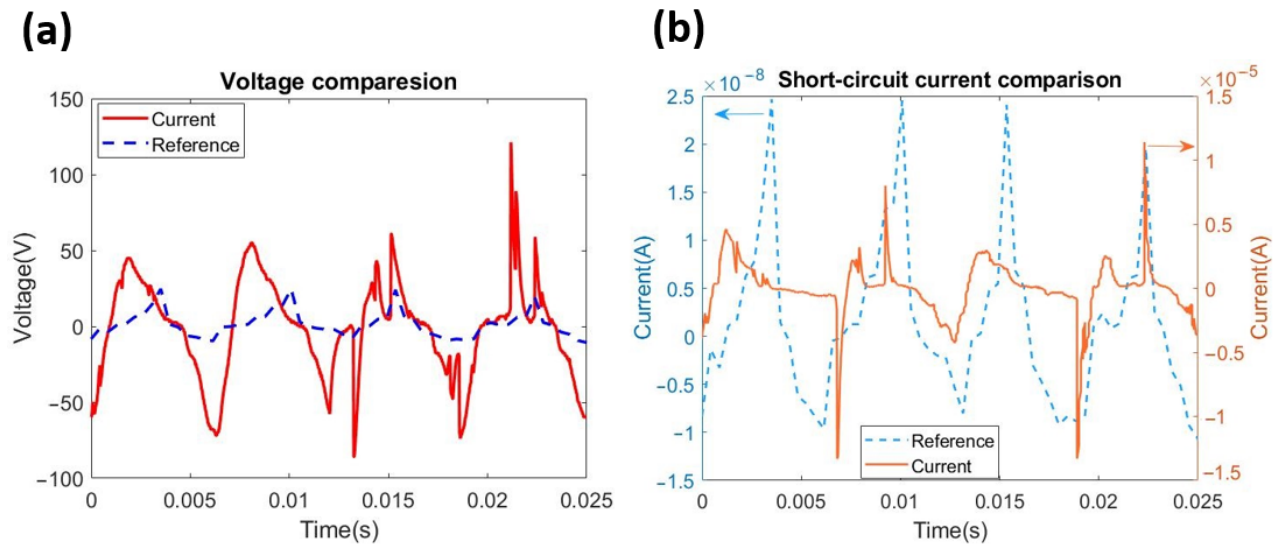
Figure 6. The results of the HDR-TENG and DC motor driven R-TENG for ( a ) the open-circuit voltage and ( b ) the short- circuit current. The dashed blue line represents the results of the DC motor-driven R-TENG used in the previous study [25], and the solid red line represents the measurement results of the proposed HDR-TENG.